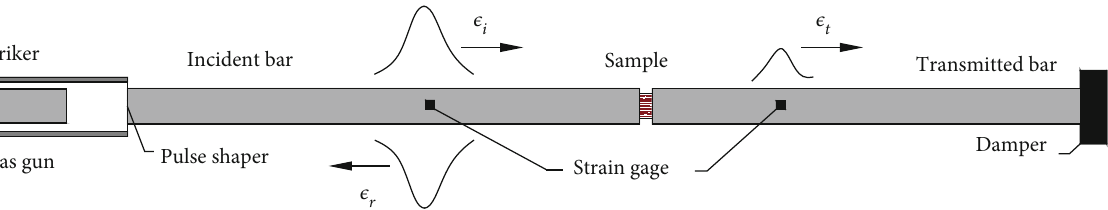
Figure 3: The SHPB apparatus.